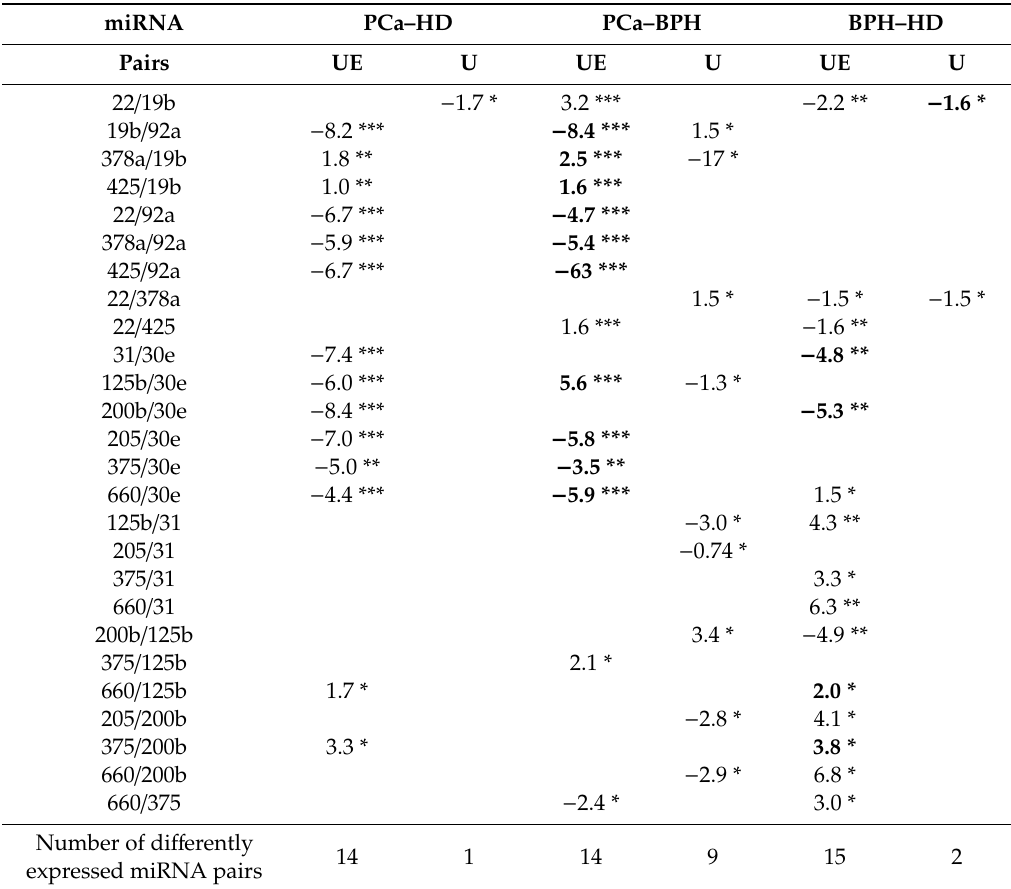
Table 1. The di ff erence of Ct di ff erence (dCt) (ddCt) values for di ff erentially expressed miRNA pairs in the following groups of comparison: prostate cancer (PCa)–healthy male donor (HD), PCa–benign prostatic hyperplasia (BPH),